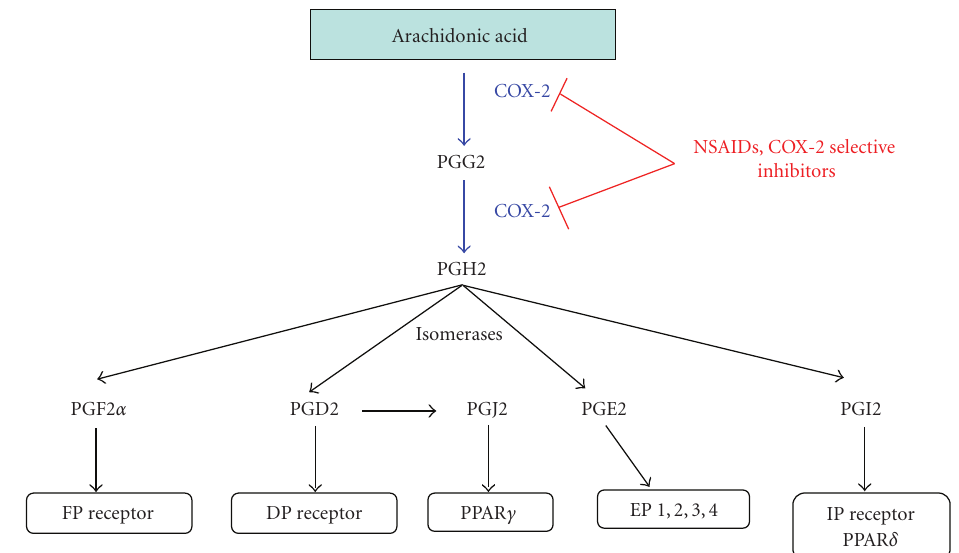
Figure 1: Metabolism of arachidonic acid by COX-2 and receptors implicated in response to prostaglandins (according to Chandrasekharan et al. [21]). Prostaglandins act through di ff erent receptors to mediate their e ff ects. PGE2 is able to bind four receptors (EP1, 2, 3, and 4). These receptors do not possess the same ligand a ffi nity and their expression is tissuedependent. The di ff erent receptors are associated with di ff erent intracellular pathways. Most of these receptors are localized in the plasma membrane but nuclear receptors PPAR γ can also bind PGJ2. Abbreviation: COX-2, cyclooxygenase-2; PG, prostaglandin; FP, prostaglandin F receptor; DP, prostaglandin D receptor; EP, prostaglandin E receptor; IP, prostaglandin I receptor; PPAR, peroxisome proliferator-activated receptor; NSAIDs, nonsteroidal anti-inflammatory